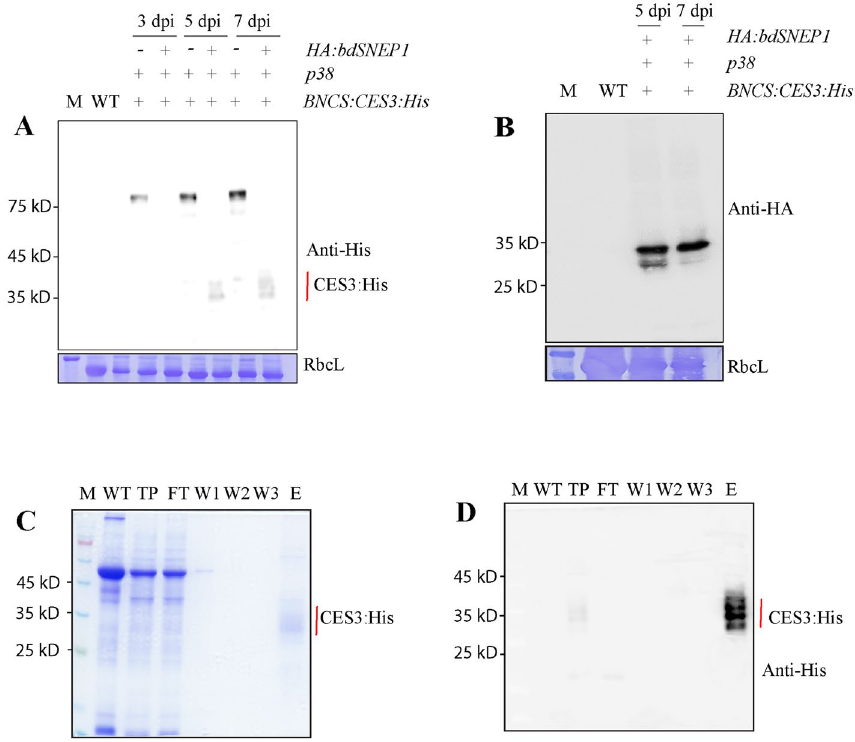
Figure 2. Release of CES3 from full-length recombinant proteins in vivo and its purification. ( A , B ) Release of CES3:His from full-length recombinant proteins by bdSENP1 in vivo. BNCS:CES3:His was co-expressed with HA:bdSNEP1 and p38 . Total protein extracts were prepared from leaf tissues harvested at different dpi, separated by SDS-PAGE, and analysed by western blotting using anti-His ( A ) or anti-HA ( B ) antibodies. ( C , D ) Purification of CES3:His. The total protein extracts were loaded onto a column with Ni 2+ -NTA-agarose beads. The Ni 2+ -NTA column was washed several times with buffer containing 20 mM imidazole, and proteins were eluted with buffer containing 250 mM imidazole. The samples were collected at different stages during purification. Proteins were separated by SDS-PAGE and detected by staining with Coomassie brilliant blue or analysed by western blotting using the anti-His antibody ( D ). M, Marker; TP, total protein extracts; FT, flow- through; W1, 2, and 3, washing off 1, 2, and 3; E,